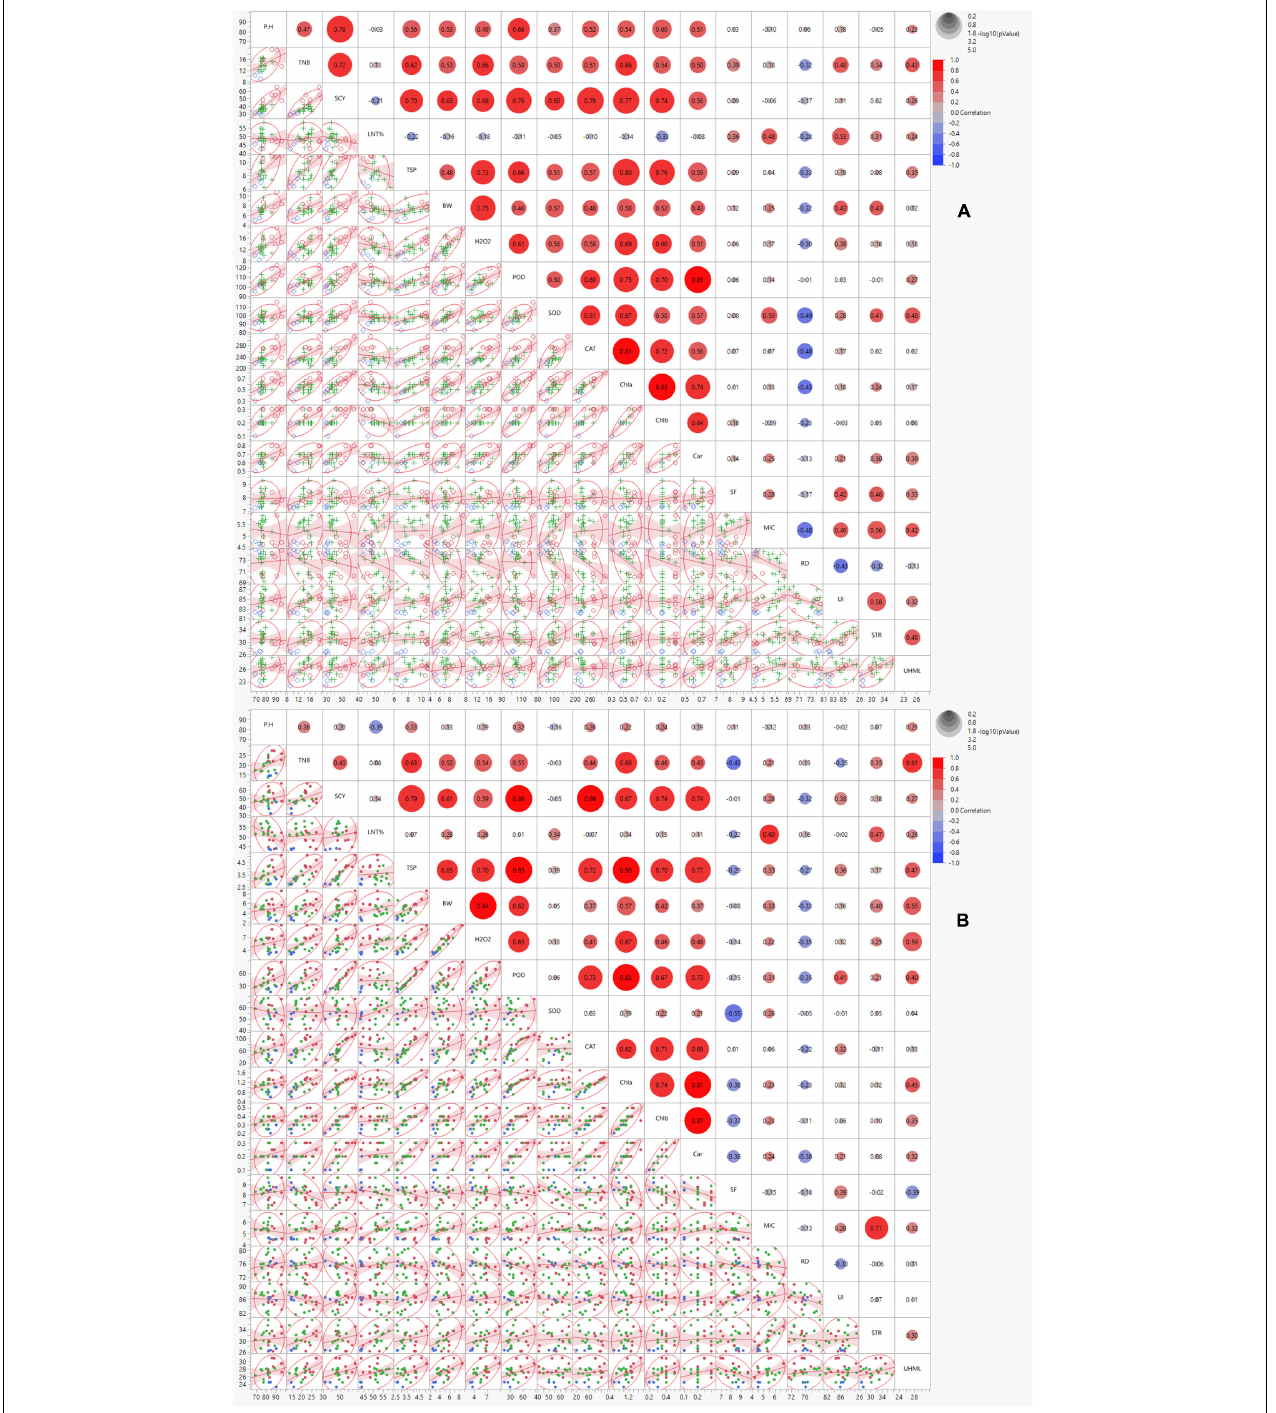
FIGURE 2 | Scatterplot correlation matrix of the 19 ionic yield and fiber-related traits of 23 cotton genotypes grown under normal (left) and high-temperature stress (right) conditions. In the upper panel, red and blue circles indicated positive and negative correlations, respectively, with increasing color intensity reflecting a higher coefficient. The lower panel indicates the bivariate density distributions with ellipses between each pair of traits and trendline of the correlated traits. PH = plant height (cm), TNB = number of bolls, BW = boll weight (g), SCY = seed cotton yield (g), SF = short fiber contents (%), STR = fiber strength (g/tex), UHML = upper half mean length (mm), MIC = micronaire value (unit), RD = reflectance, UI = uniformity index (%), H 2 O 2 = hydrogen peroxide ( µ mol/g), CAT = catalase (U mg - 1 protein), POD = peroxidase (U mg - 1 protein), SOD = superoxide dismutase (U mg - 1 protein), TSP = total soluble protein (mg g - 1 FW), Chl a and b = chlorophyll contents (A,B) (mg g - 1 FW), Caro = carotenoid (mg g - 1 FW).